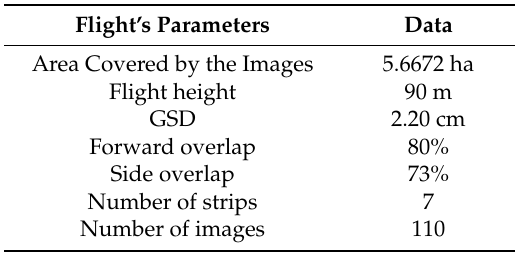
Table 2. Parameters of the flight plan.